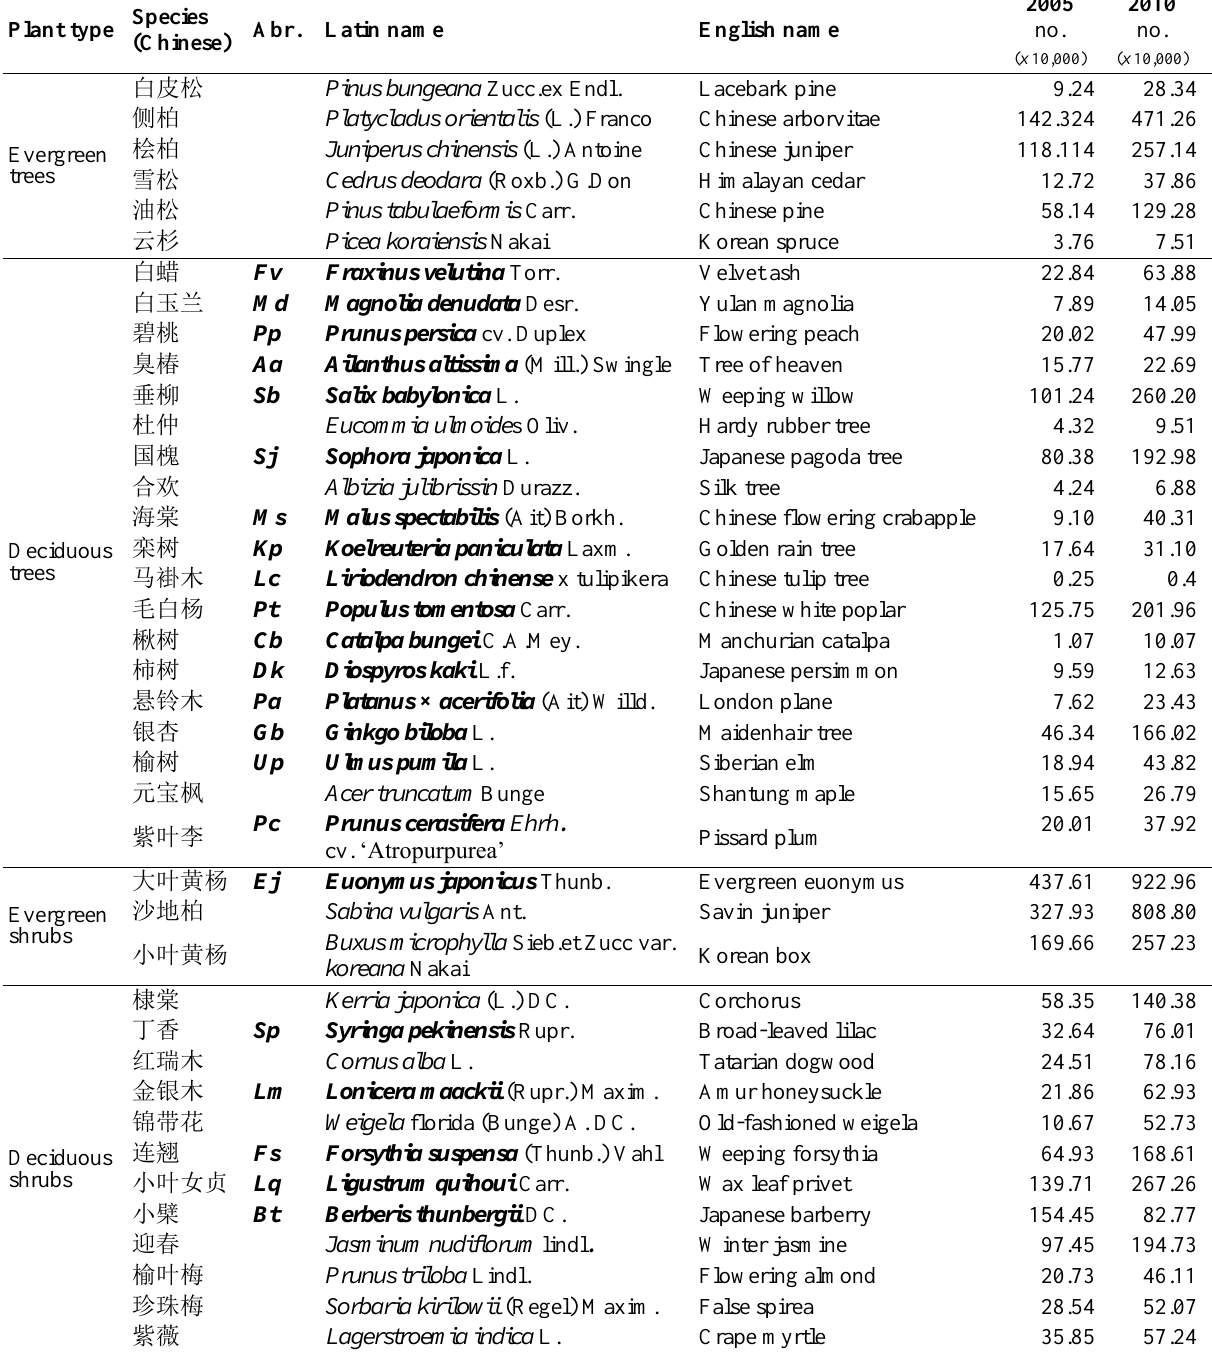
Table 1. Absolute abundance of woody plant species found in 2005 and 2010 in the urban area of Beijing. In bold, the 22 broadleaf species studied and the abbreviation (Abr.) used in the text for each species. The number of trees and thus the urban vegetation cover was increased between 2005 and 2010 in order to improve environment air quality for the 2008 Olympic Games. The data were derived from the municipal census data (the data of 2005 are available in Beijing Municipal Bureau of Landscape and Forestry, 2006; data for 2010 were collected in the same way as 2005,